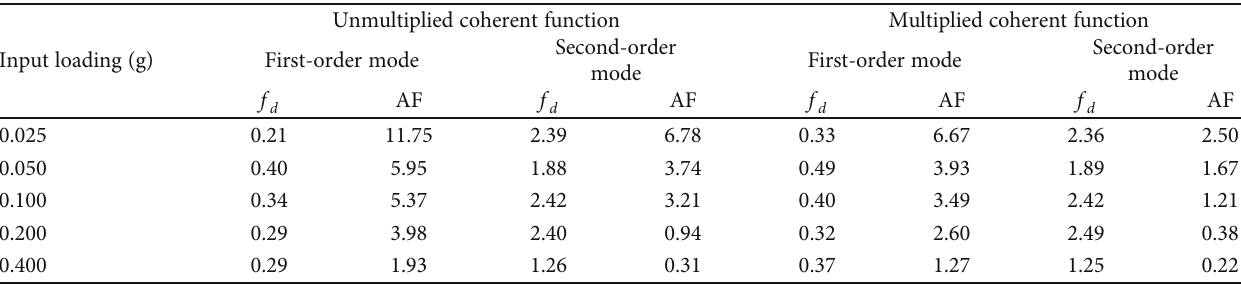
Table 1: Ampli fi cation factor and frequency of di ff erent vibration modes loaded with di ff erent conditions for the model for the surface without water. f : predominant frequency; AF: ampli fi cation factor. d Input loading (g)